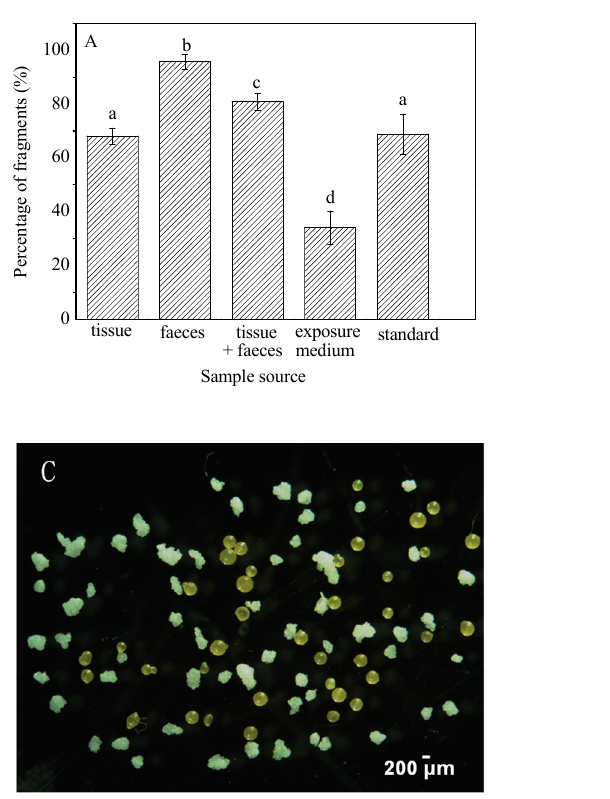
Figure 4. Shape ( A ) and size ( B ) distribution of microplastics in different media (tissue, feces, and exposure medium) over 48-h exposure. Typical extracted microplastics in tissue ( C ) and feces ( D ) exposure medium samples are shown. Straight lines in Figure 4B show medians and interquartile. Differences between groups were analyzed for significance using Tukey’s multiple comparison test. Different letters above columns in the histogram and one side in the violin plot indicate significant differences ( p < 0.05).